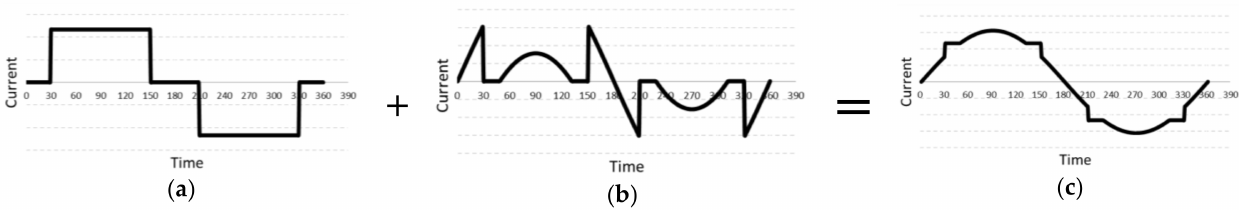
Figure 13. Current waveforms in phase a of the HTR. ( a ) Input current in rectifier 1. ( b ) Input current in rectifier 2. ( c ) Input current (distorted sinusoidal) in the